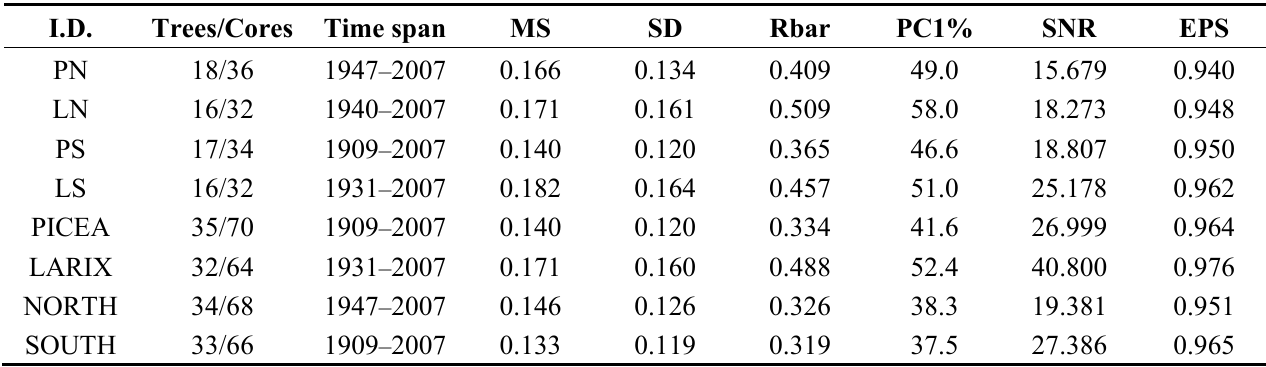
Table 2. Characteristics of tree-ring width chronologies.